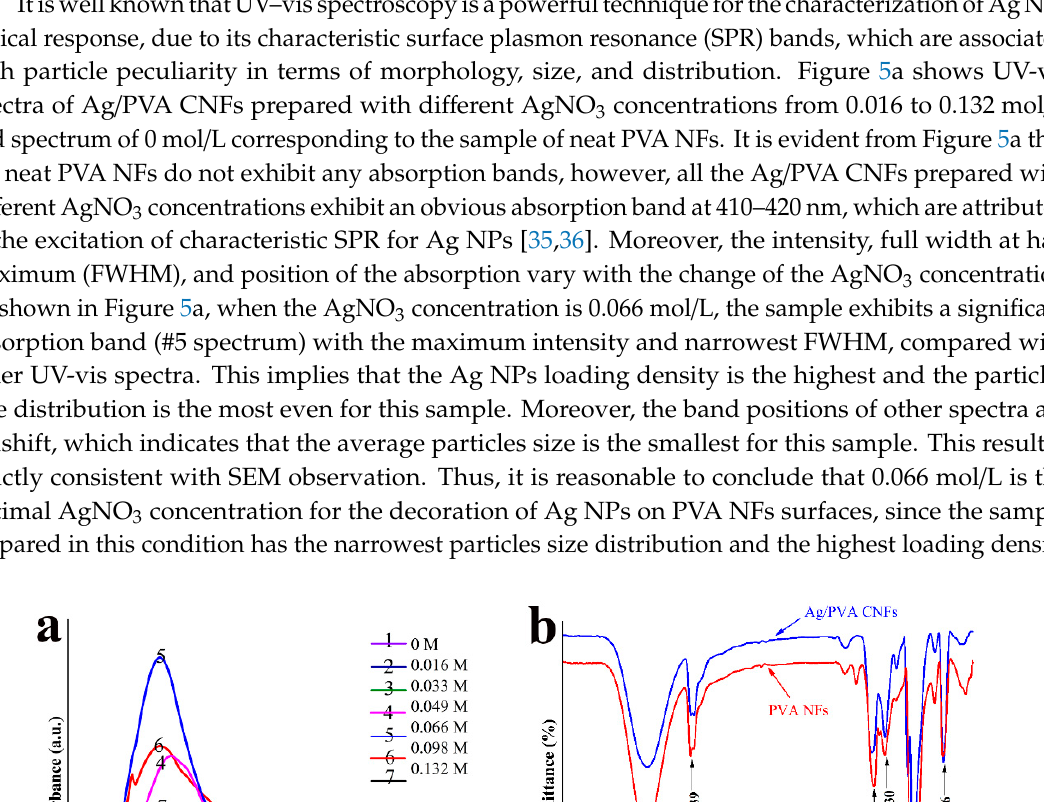
Figure 4. ( a ) XRD patterns of PVA NFs and Ag/PVA CNFs, ( b ) TEM image of Ag/PVA CNFs prepared with AgNO 3 concentration at 0.066 mol/L, the inset is the SAED patterns of Ag NPs.